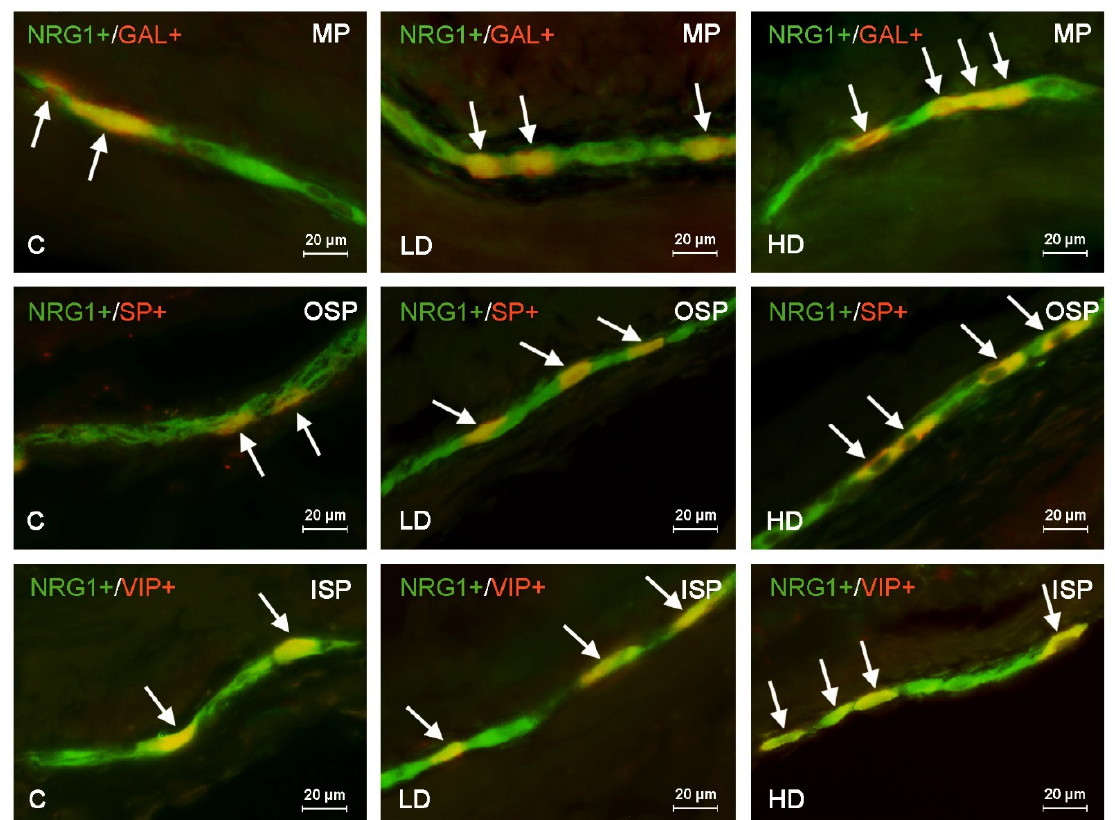
Figure 1. Distribution pattern of nerve cells immunoreactive to Neuregulin 1 (NRG1) and other neuronal substances studied—galanin (GAL), substance P (SP) or vasoactive intestinal polypeptide (VIP)—in the muscular plexus (MP), outer submucous plexus (OSP) or inner submucous plexus (ISP) in the porcine caecum under physiological conditions (C) and under the impact of a low dose (LD) and a high dose (HD) of BPA. The pictures are the result of the overlap of both stainings. Neurons immunoreactive for both NRG1 and other of the neuronal substances studied are indicated with ar- rows.